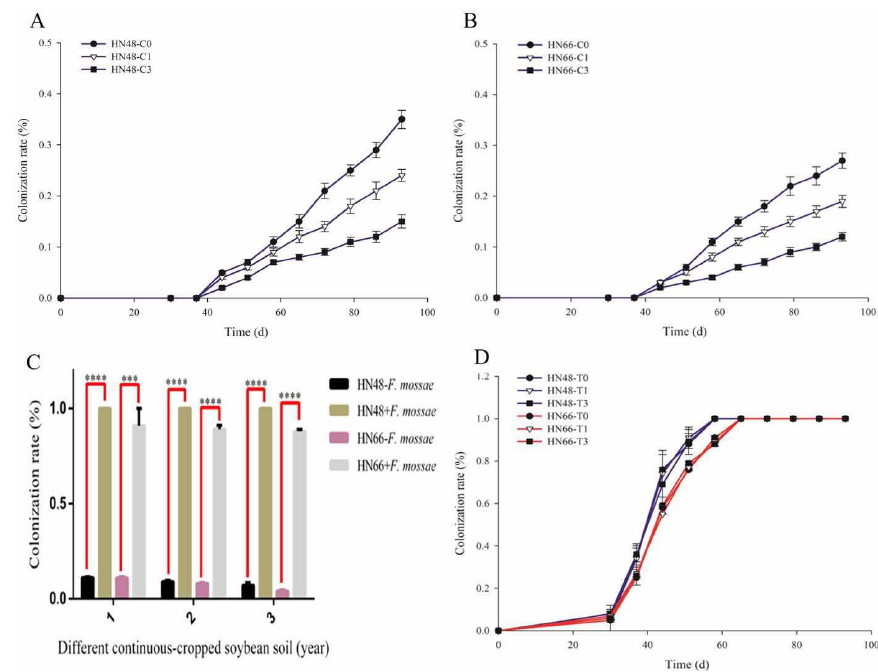
Figure 2. The AMF colonization rate of two soybean cultivars under different continuous ‐ cropped year soil in potted ‐ experiments: 1 means soybean were planted the normal soil; 2 means soybean were planted in one ‐ year continuous cropping soybean soil; 3 means soybean were planted in three ‐ year continuous cropping soybean soil; C0/T0 means soybean were planted the normal soil without/with inoculated F. mosseae ; C1/T1 means soybean were planted in one ‐ year continuous cropping soybean soil without/with inoculated F. mosseae ; C3/T3 means soybean were planted in three ‐ year continuous cropping soybean soil without/with inoculated F. mosseae . Note: All experiments were conducted in potted ‐ experiments. ( A , B , D ) x ‐ axis represents which day detected the AMF colonization rate of two soybean cultivars; and ( C ) represents the year of continuous cropping soybean soil. Each value represents the average of six independent experiments and the error bars represent standard deviations. Asterisks indicate the significance of differences between the samples. p values were calculated by Student’s t -test. Quadruple asterisk indicates p < 0.0001.